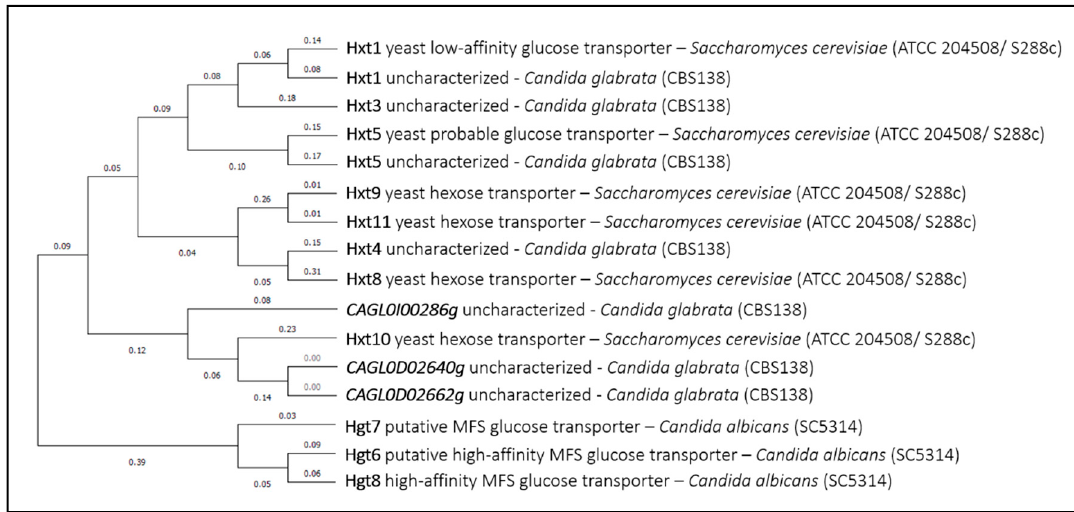
Figure 9. HXT (Hexose transporters) phylogenetic analysis. The tree with the highest log likelihood is shown. This analysis involved 16 amino acid sequences. There were a total of 594 positions in the final dataset. Evolutionary analyses were conducted in MEGA X.